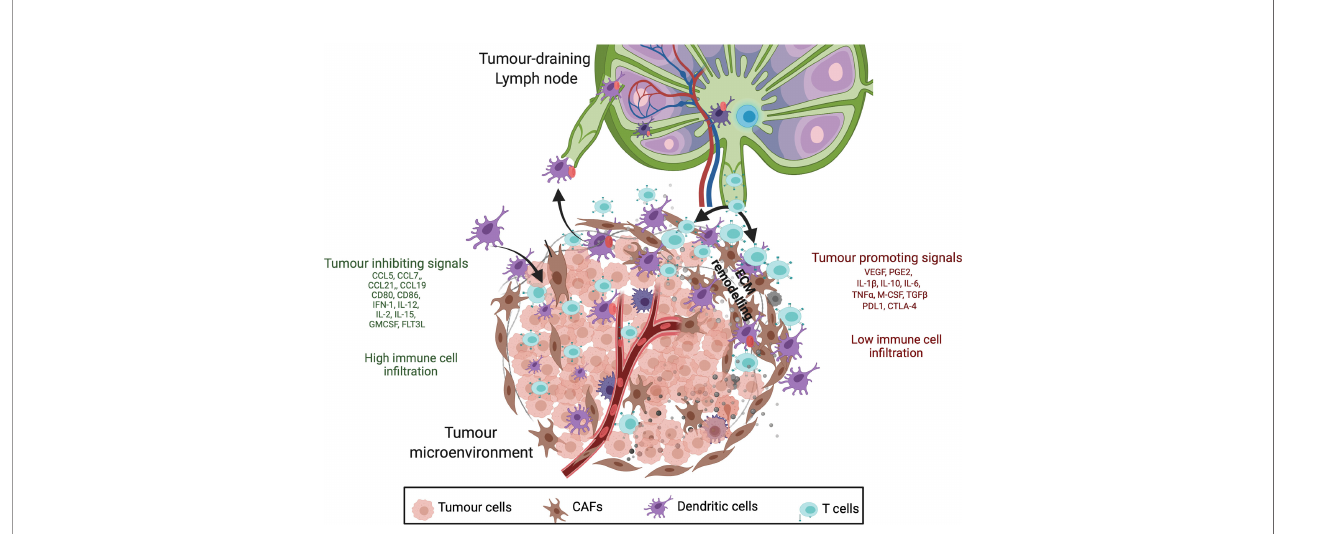
FIGURE 1 | Cancer inhibitory and cancer-promoting signals within the tumour microenvironment (TME). Anti-tumour response is initiated by antigen recognition and traf fi cking by mature DCs to the tumour draining lymph node (TDLN) which involves upregulation of chemokine receptors (CCR7), MHC class II, co-stimulatory molecules (CD80 and CD86), in fl ammatory molecules (IL-12, INF-1) and adhesion molecules (ICAM-1) (listed in green). Having said that, immunosuppressive nature of TME secretes tumour promoting in fl ammatory mediators (listed in red) such as prostaglandin E2, cytokines (IL-10, IL-6, TGFß), chemokines (CXCL1) and growth factors (VEGF) that impede anti-tumour response by altering DC phenotype, T-cell in fi ltration and ECM remodelling. These differences result in poor surveillance by DCs and lower in fi ltration of T cells in tumours with immunosuppressive molecules (red).